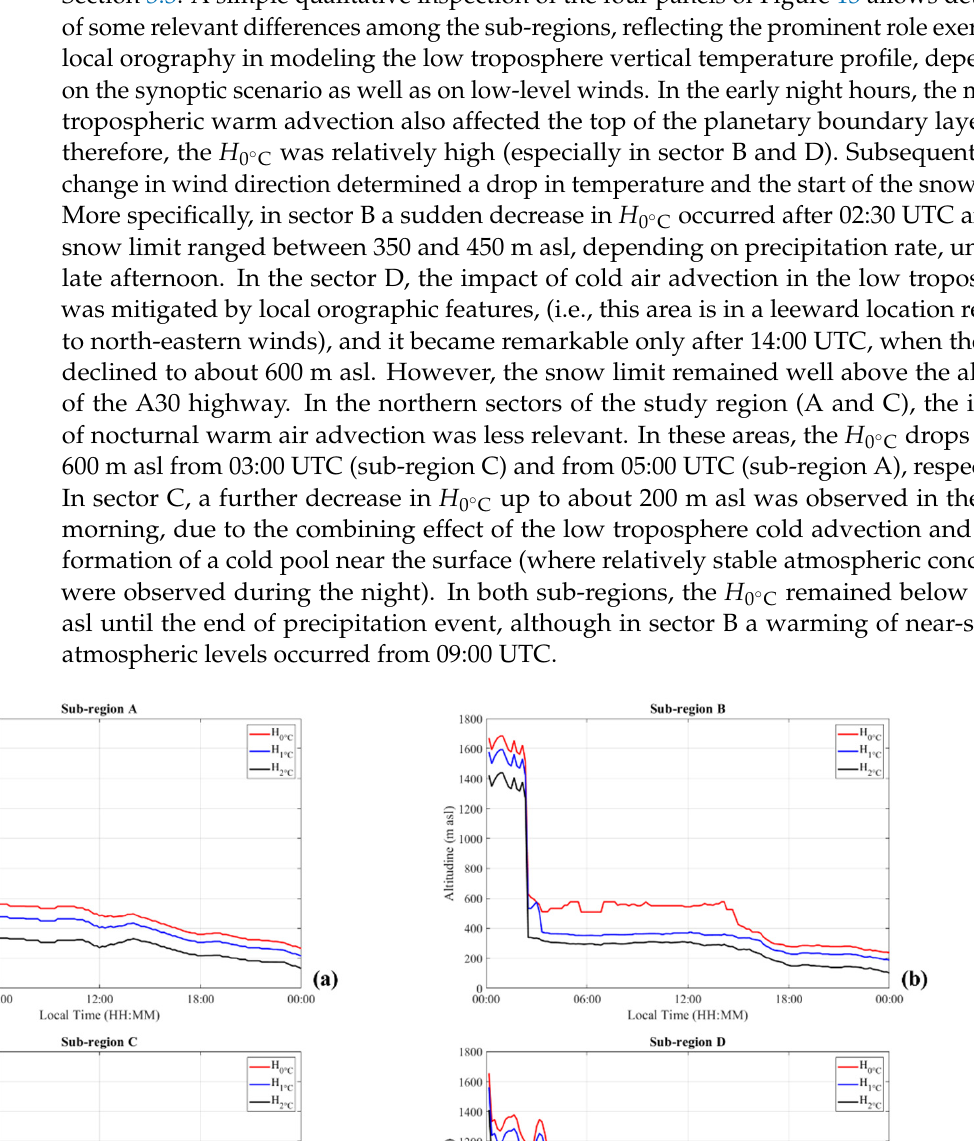
each radar composite grid was categorized as rain (in green), mixed (in yellow) and snow (in red). The snowfall precipitation started around 01:10 UTC and, initially, it was confined to the eastern sector of the A16 highway (Figure 14a), in the proximity of Scampitella pass (which is marked as a filled-in black diamond). In the next two hours, as a result of the lowering of H 0 °C in both B and C sub-regions, the snowfall also affected the area of Montemiletto and Monteforte Irpino passes (highlighted as filled-in black squares and circles, respectively), as revealed by Figure 14b. The most critical conditions occurred between 05:00 and 07:00 UTC, when snowfall was detected and observed over a large part of the A16 highway between Monteforte Irpino and Candela (see Figure 14c, which refers to 05:20 UTC). During the morning hours, thanks to a slight warming of near-surface atmospheric layers occurred in the sub-region C, there was a relaxation of snow-related challenges, which were restricted to the neighborhood of the three passes and to the A16 segment between Scampitella pass and Candela (see Figure 14d). A new temporary worsening of conditions was observed during the afternoon, due to a further decrease in H 0°C. It is very easy to note that no snowfall precipitation was detected (and truly observed) in the other two motorways of interest (A1 and A30).